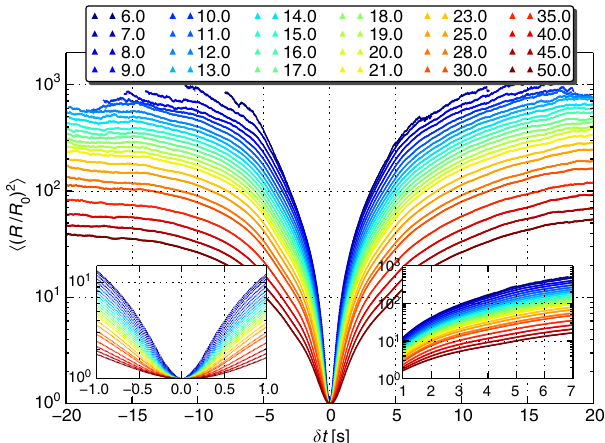
Fig. 2 on a semi-logarithmic scale; here, and in all that follows, h ¼ i denotes ensemble averages differing by their initial R 0